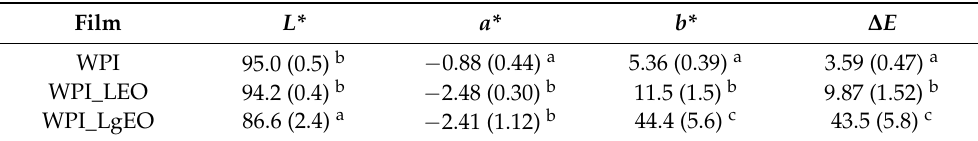
Table 1. L* , a* , b* colour parameters and total colour difference ( ∆ E ) of whey protein films with lemon (WPI + LEO) and lemongrass (WPI + LgEO) essential